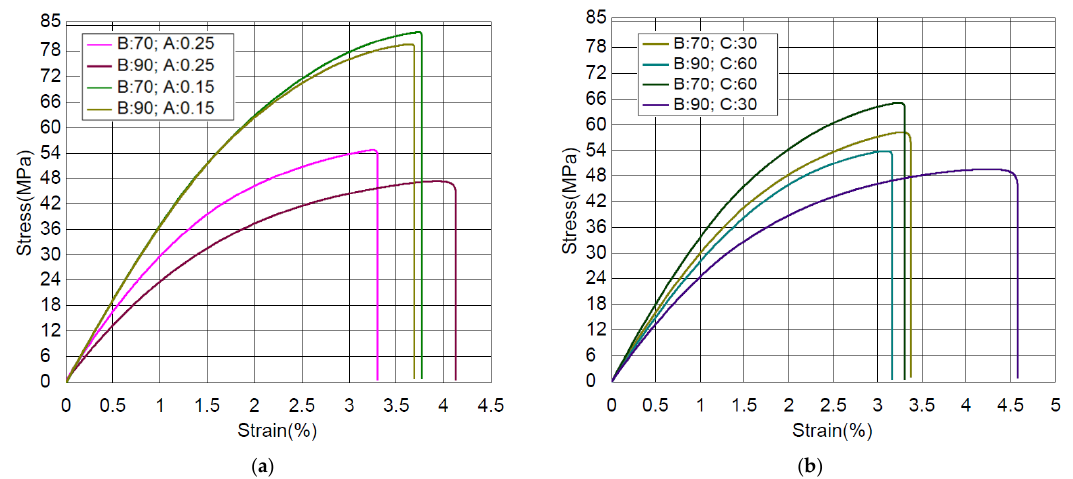
Figure 8. The stress – strain curves at printing speed of 70 mm/s and 90 mm/s: ( a ) layer thickness of 0.15 mm and 0.25 mm; ( b ) raster angle of 30° and 60°. To increase the tensile strength of CFPR parts, it is necessary to select smaller values